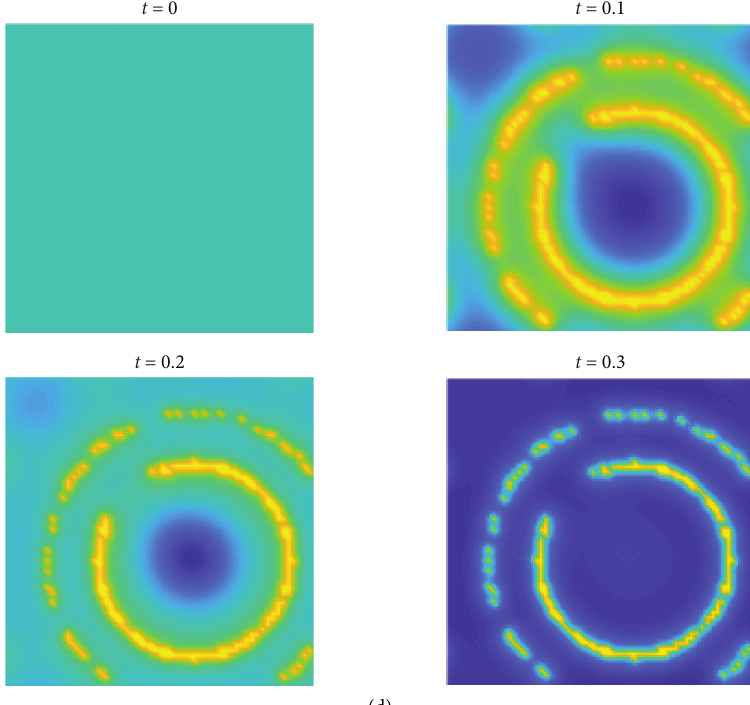
Figure 12: Numerical solution and Turing pattern of Experiment 2 with initial condition u ( x,y, 0 ) � sin ( π (( x − 0 . 4 ) 2 + ( y + 0 . 4 ) 2 )) + e − 20 (( x + 0 . 4 ) 2 +( y − 0 . 4 ) 2 ) and v ( x,y, 0 ) �